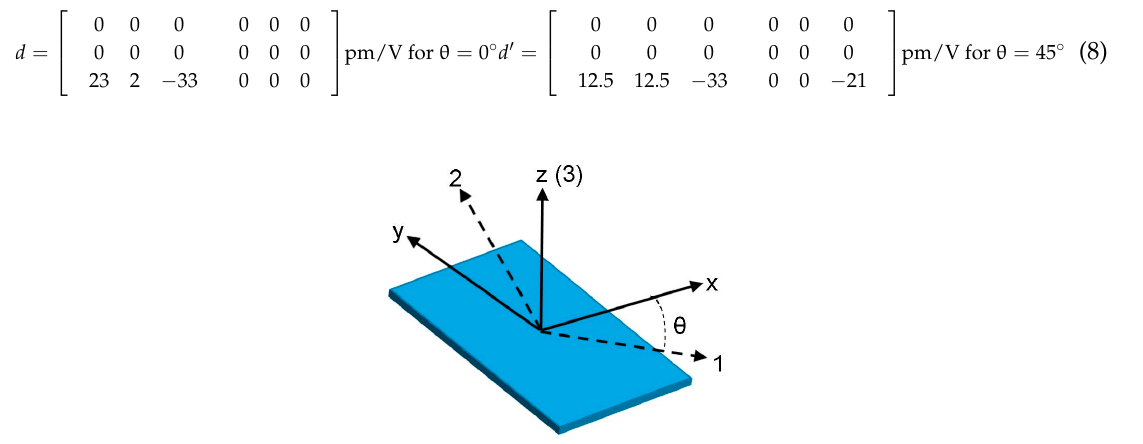
Figure 1. Sketch for the coordinate transformation of PVDF material properties.